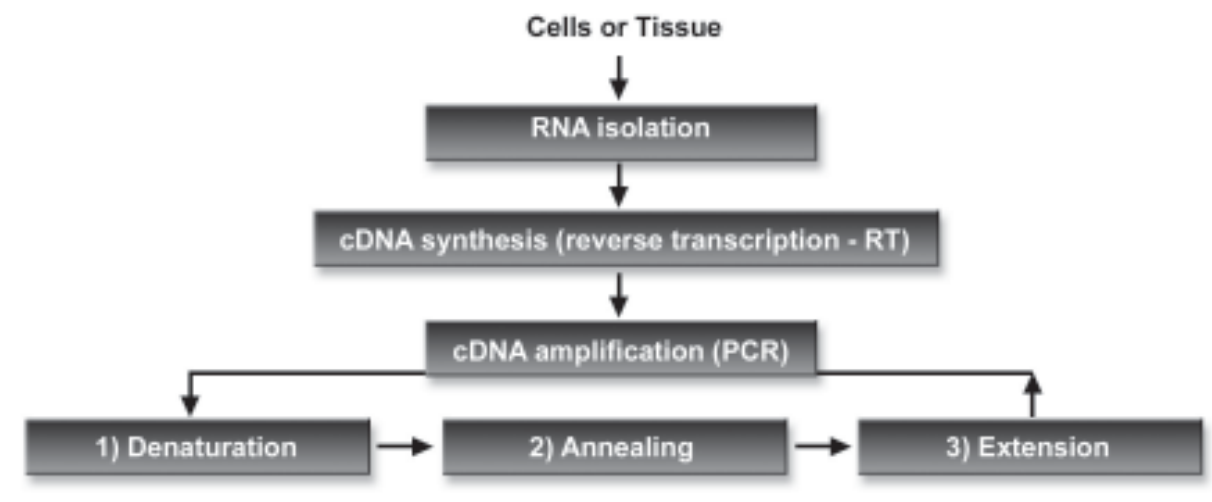
FIGURE 3 - Schematic diagram of RT-PCR showing that RNA isolated from cells or tissue is used as substrate in reverse transcription for synthesis of cDNA that will serve as template for amplification by